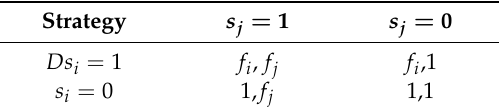
Table 4. Table of game benefits.